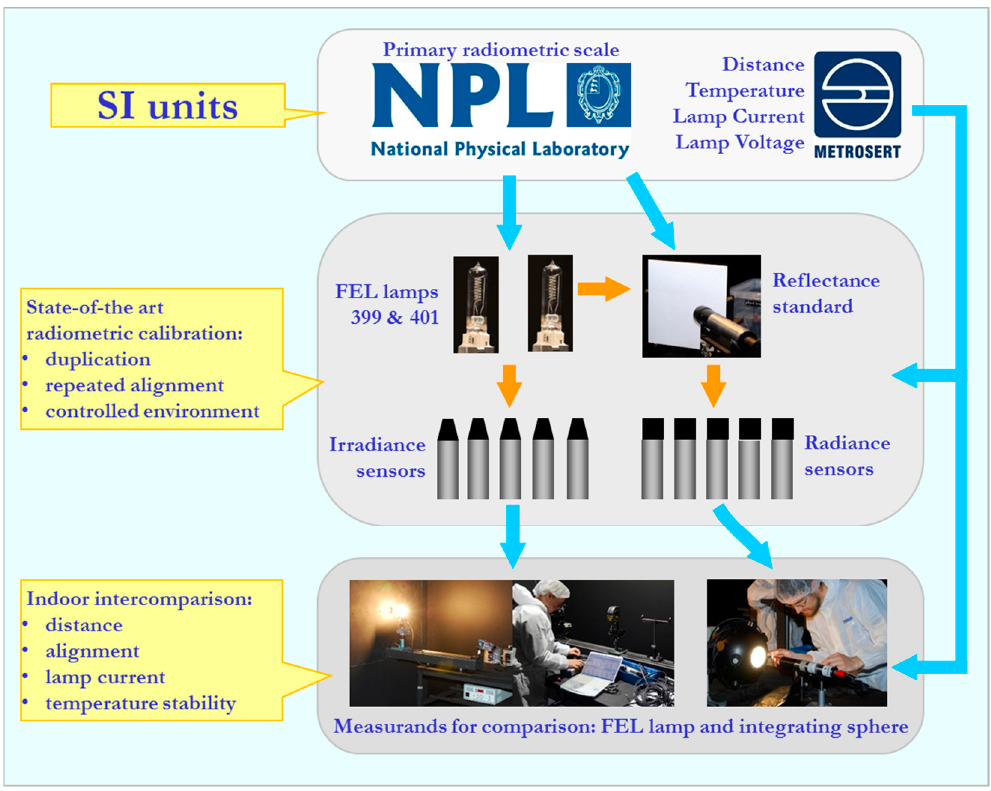
Figure 1. Traceability scheme of the LCE-2 for validation of indoor measurement uncertainties as specific to the present study.